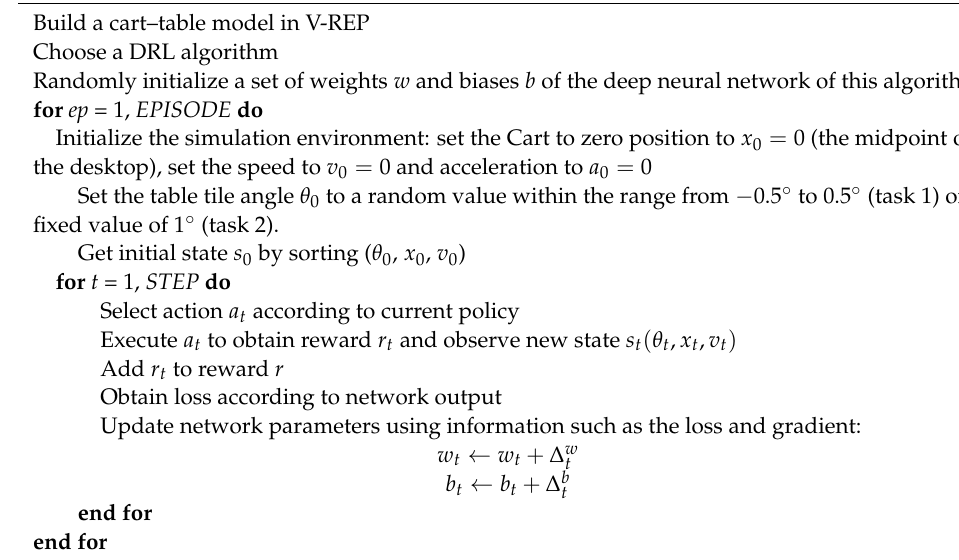
Algorithm 1. Cart–table model with DRL algorithms. Build a cart–table model in V-REP Choose a DRL algorithm